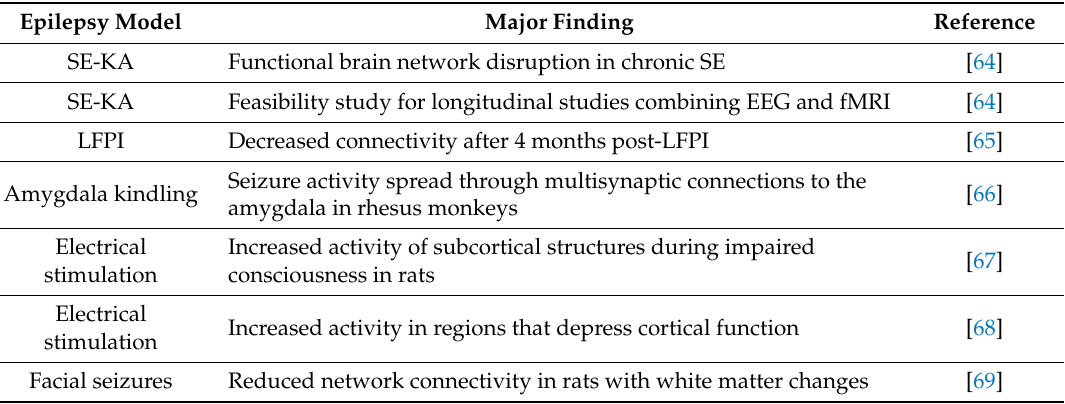
Table 6. List of functional MRI (fMRI) studies and potential biomarkers for